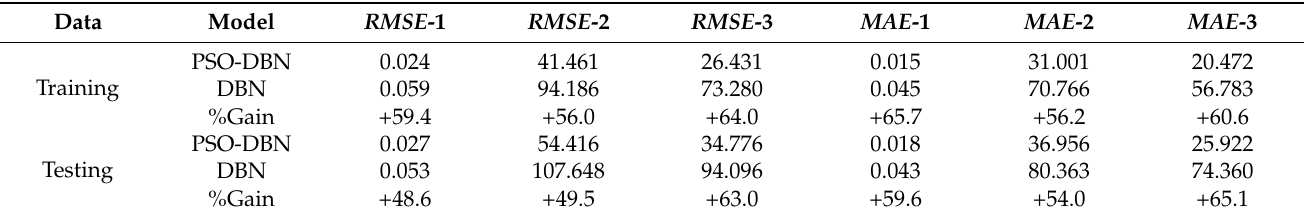
Table 6. Comparison of evaluation metrics between PSO-DBN model and single DBN model (a).